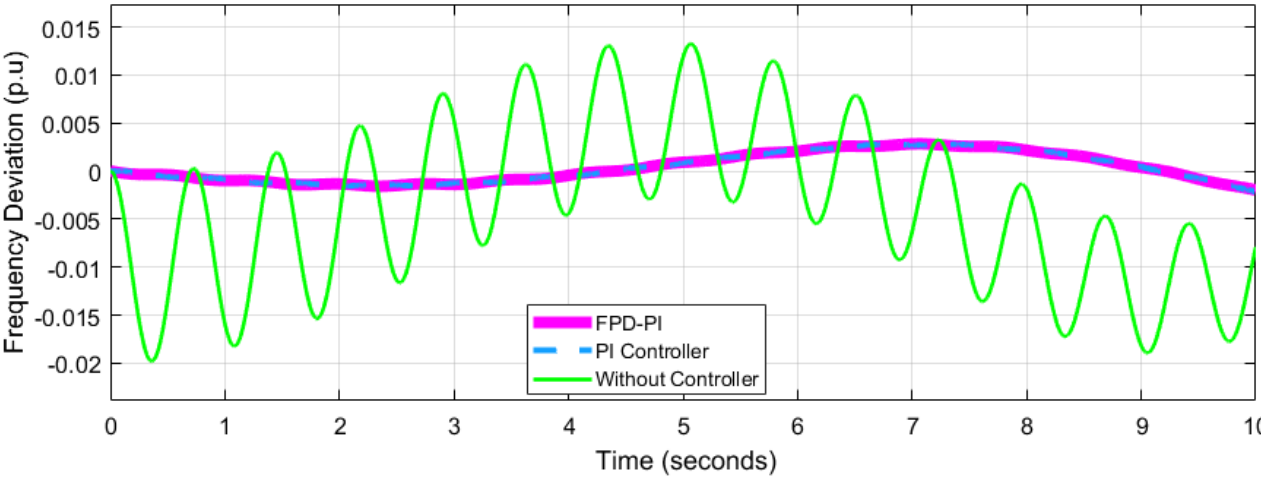
Figure 6. Case 3: frequency deviation at (K p = −1.7251, K i = −0.0012) for network 1.